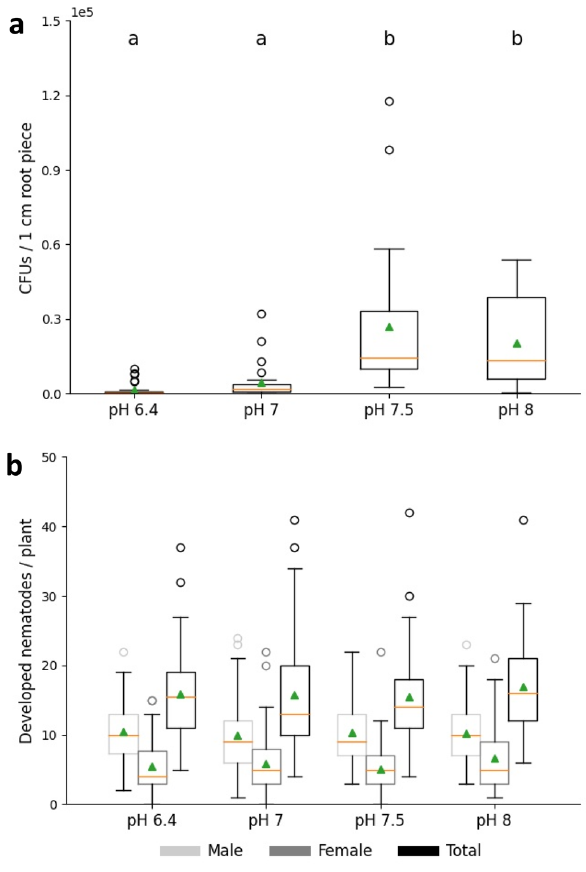
Figure 2. Impact of pH on colonization of Bacillus firmus I-1582 ( a ) and infection of Heterodera schachtii ( b ) at Arabidopsis thaliana roots. Results are expressed as the mean (orange line) and median (green triangle) ± standard error of three independent biological replicates [n ≥ 22 ( a ); n ≥ 50 ( b )]. Different letters indicate statistically significant differences among treatments according to Dunn’s Method ( p < 0.05). No significant differences were observed for ( b